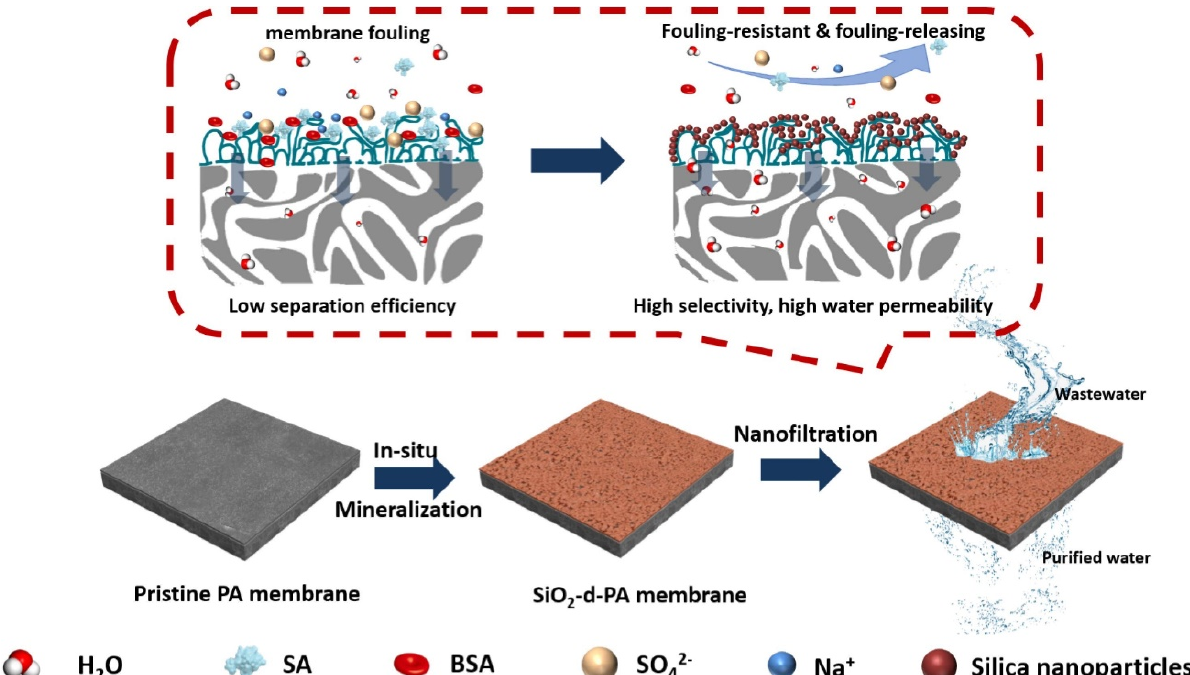
Polymers 2023 , 15 , x FOR PEER REVIEW Figure 4. Fabrication of SiO 2 − coated polyamide-based membrane for high-capacity rejection and antifouling activity. Adapted with permission from Istirokhatun et al. [123] . Copyright (2021). Elsevier. Table 2. A summary of enhancements in properties of SiO 2 nanoparticle-based nanocomposite membranes.